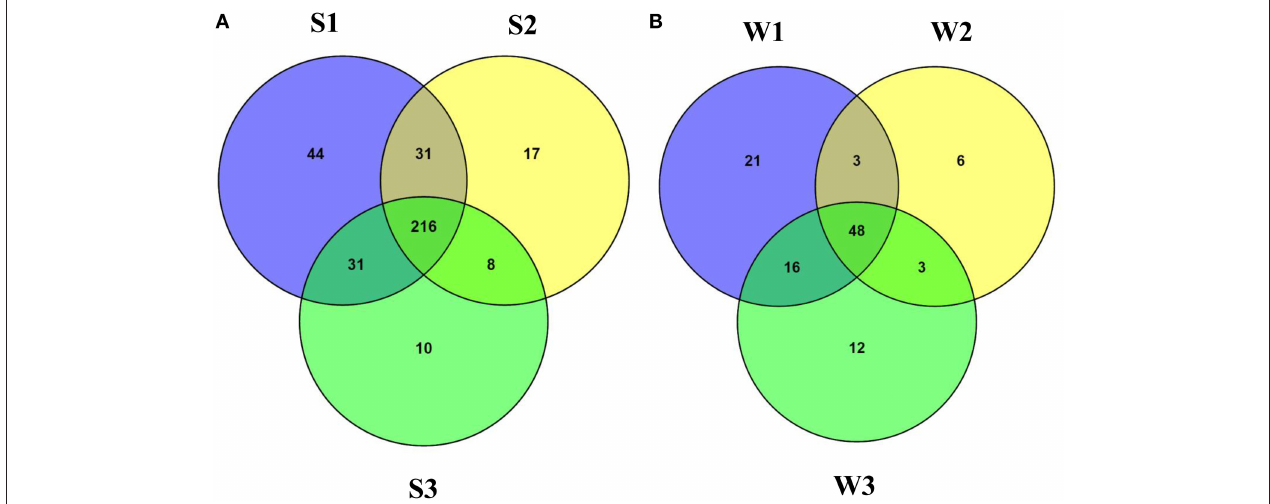
FIGURE 2 | Venn diagram demonstrating unique and shared OTUs at family level (A) among the sediment samples and (B) among the water samples of the Lonar